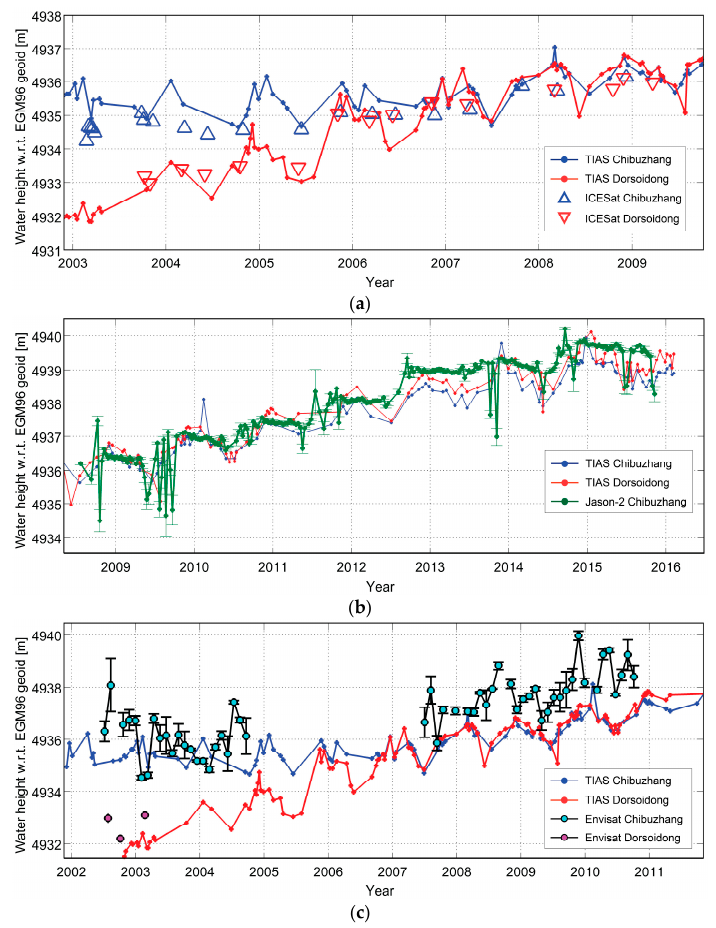
Figure 4. Time series between TIAS estimates (blue line for Chibuzhang Co and red line for Dorsoidong Co, respectively) and ( a ) ICESat measurements (blue triangle in Chibuzhang and red triangle in Dorsoidong); ( b ) Jason-2 (green lines); and ( c ) Envisat.